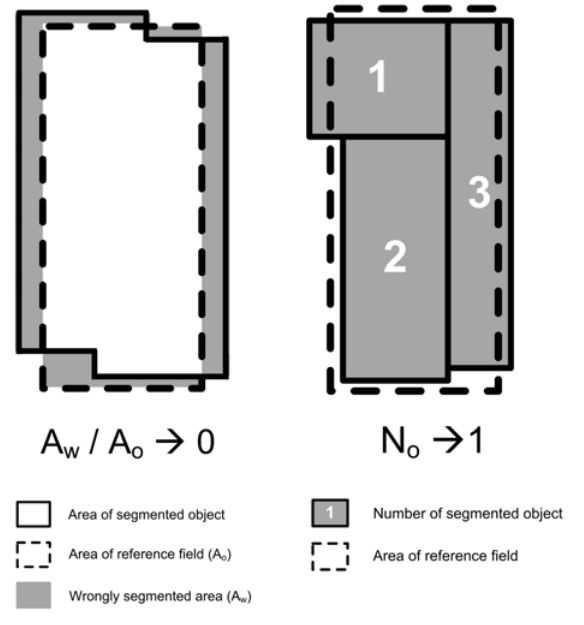
Figure 4. Metrics used for segmentation suitability